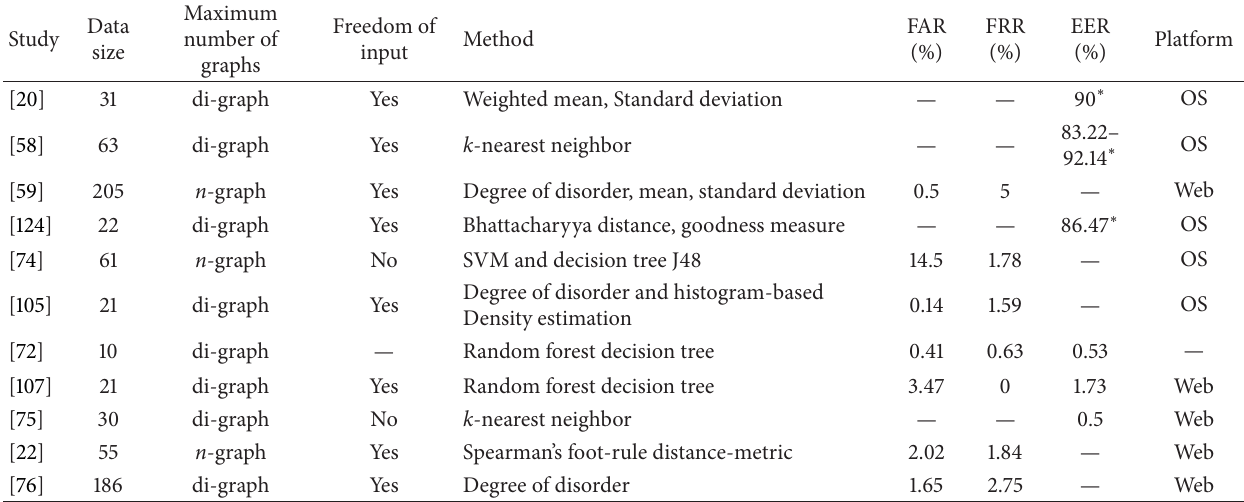
Table 6: Comparison between research works in dynamic authentication mode.